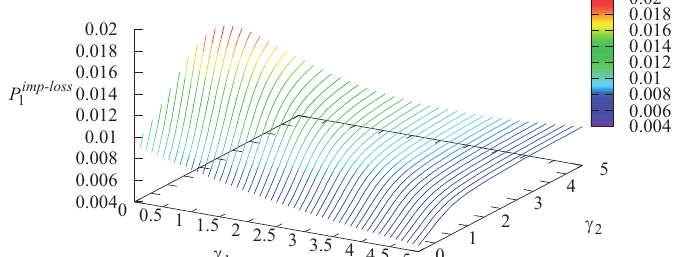
− loss that an arbitrary customer will be lost due to 1